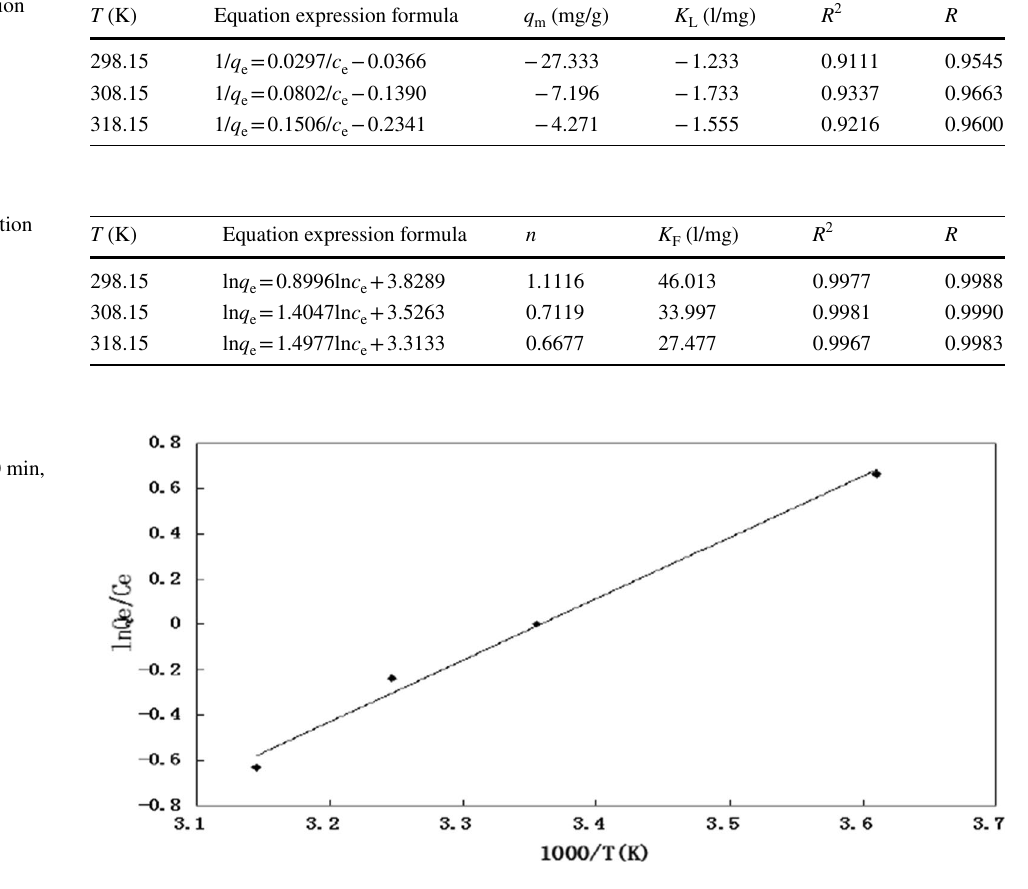
Table 2 Langmuir adsorption isotherm equation data